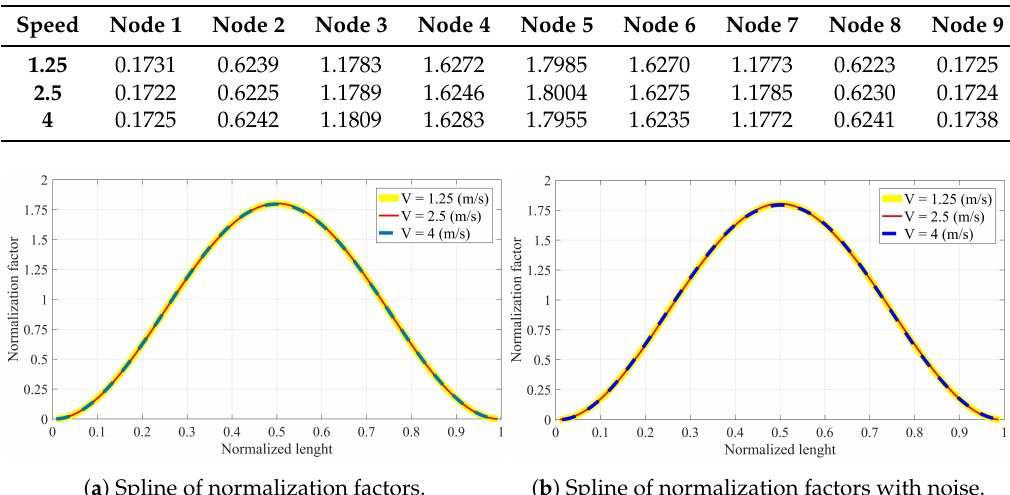
Table 6. Slopes corresponding to different velocities and scenarios.